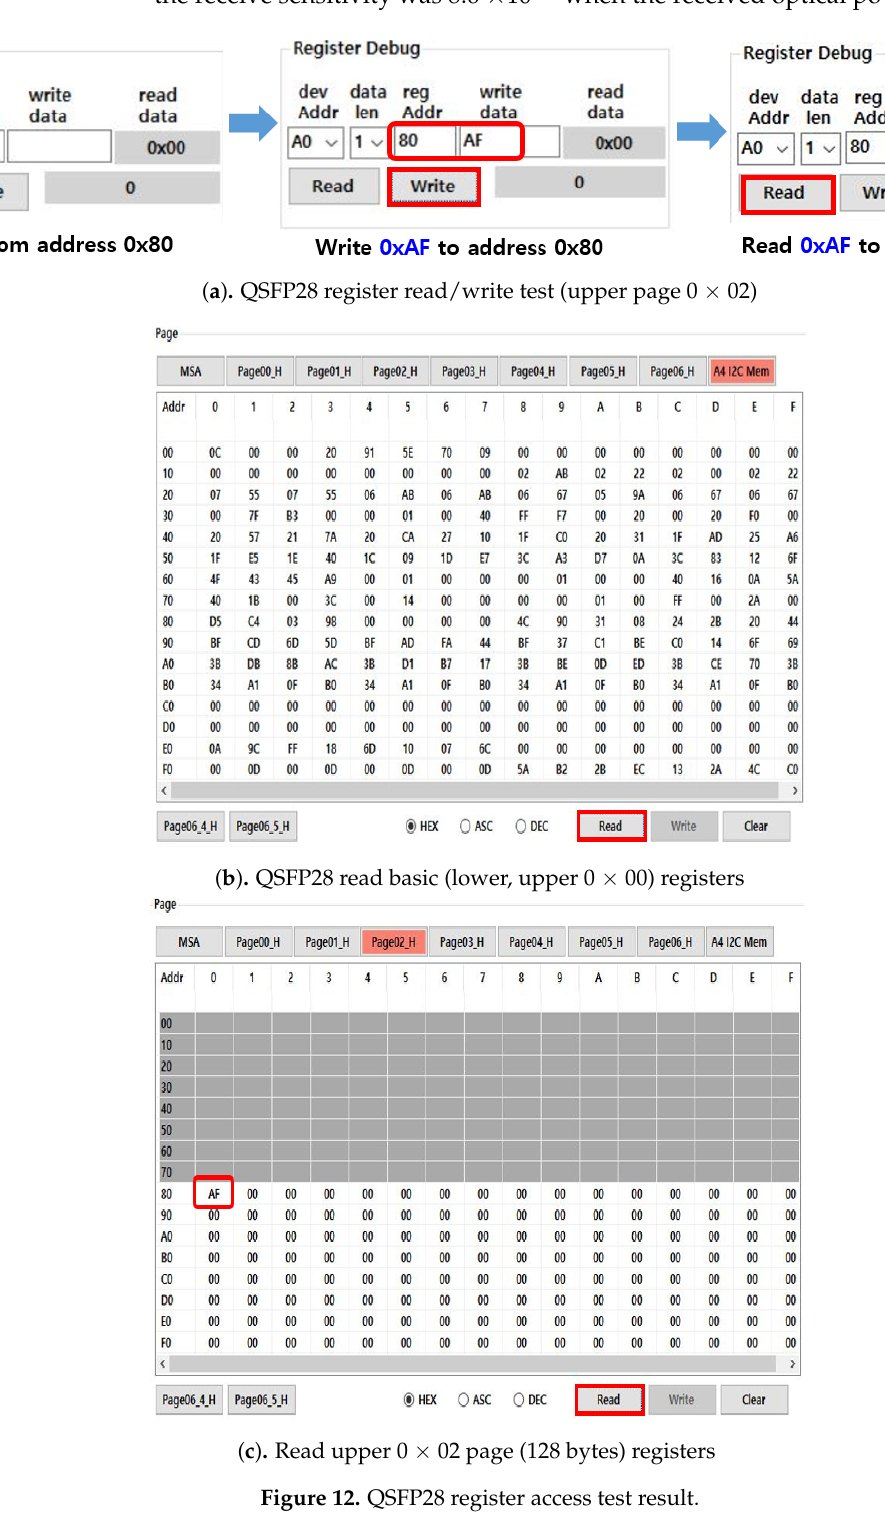
Figure 12. QSFP28 register access test